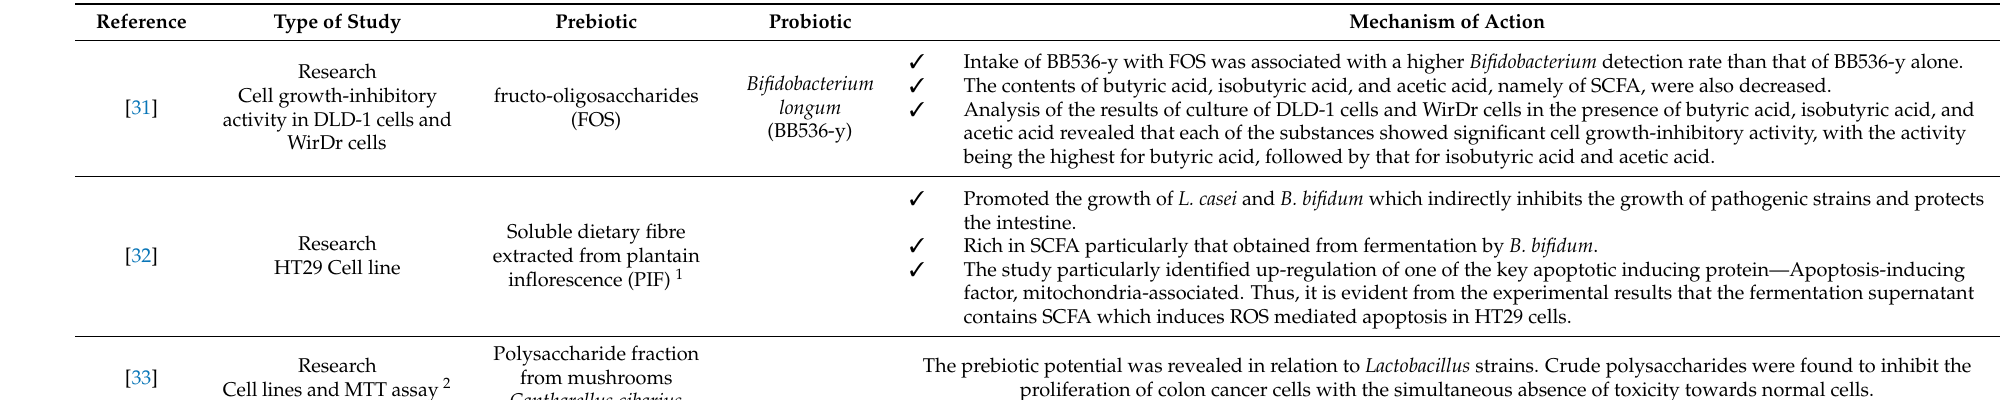
Table 3. Prevention of Colorectal cancer (CRC) using various prebiotics in cell